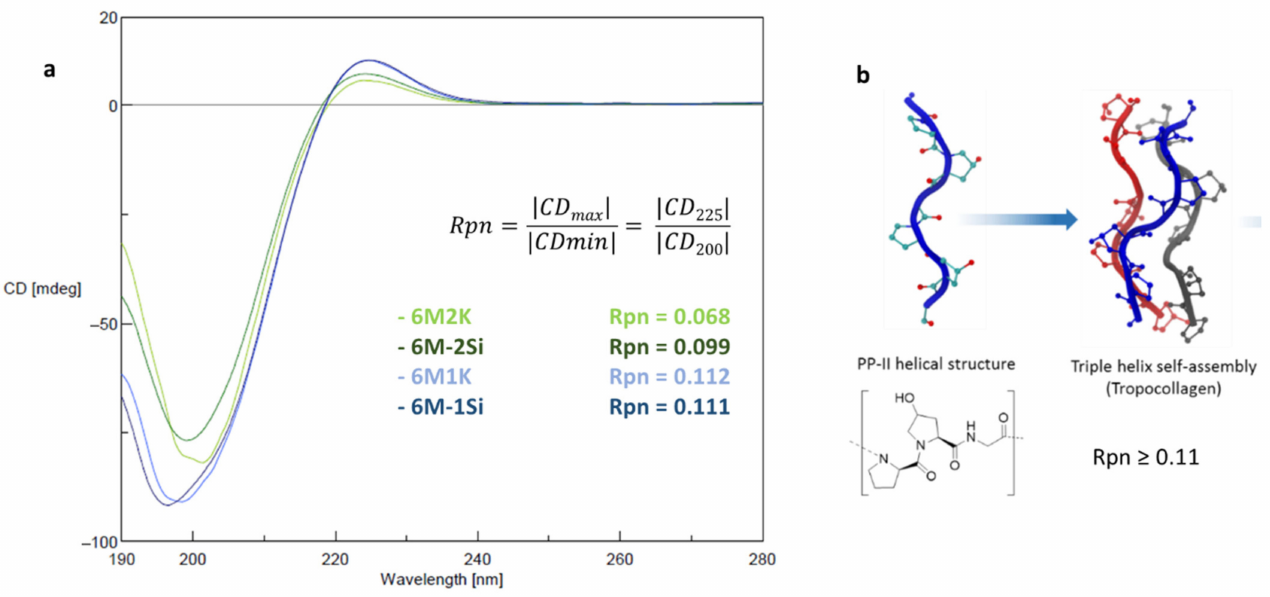
Figure 3. ( a ) CD spectrum of collagen-like peptides and their hybrid relatives with the calculated Rpn value and ( b ) schematic representation of PPII and triple helix formation (adapted from